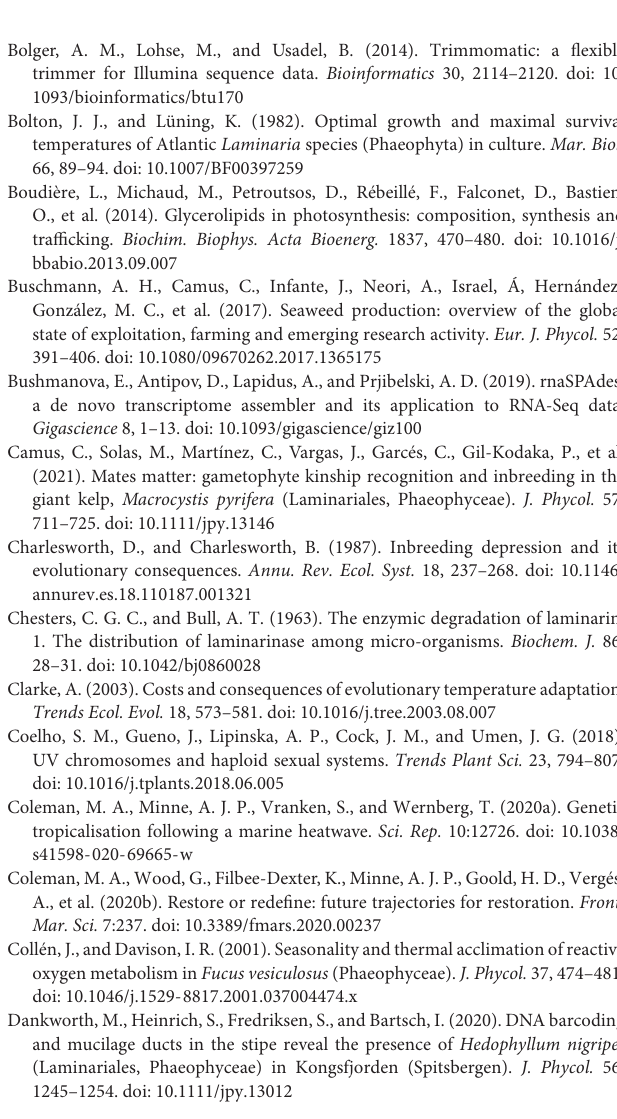
Supplementary Table 1 | Differentially expressed KEGG genes which correspond to functional groups of protein metabolism and biogenesis of mitochondria and ribosomes shared by sporophytes of the Helgoland selfing and both reciprocal